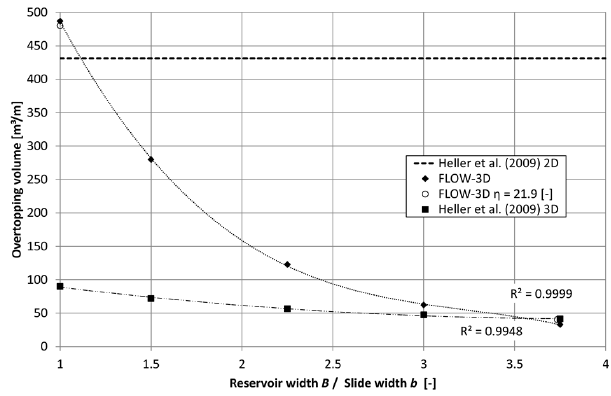
Figure 10. Overtopping volume V depending on the slide width b and reservoir width B including